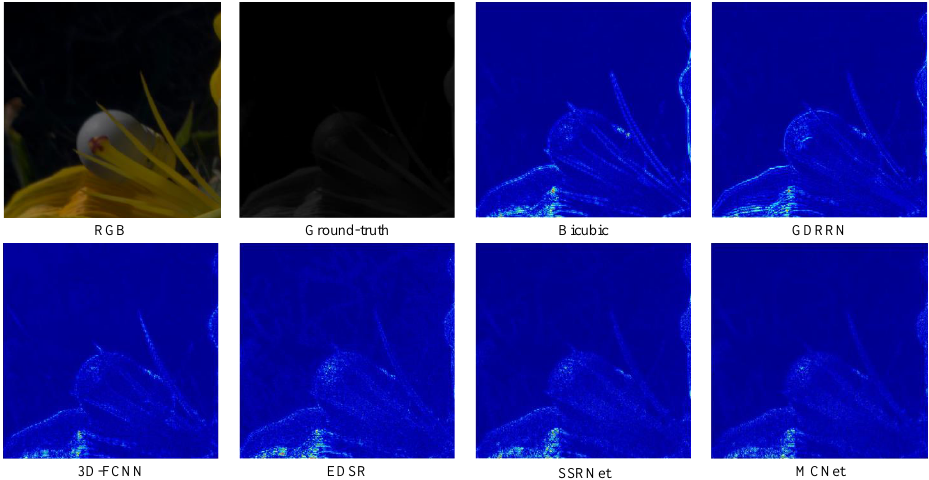
Figure 9. Absolute error map comparisons for image Bom_Jesus_Bush on Foster